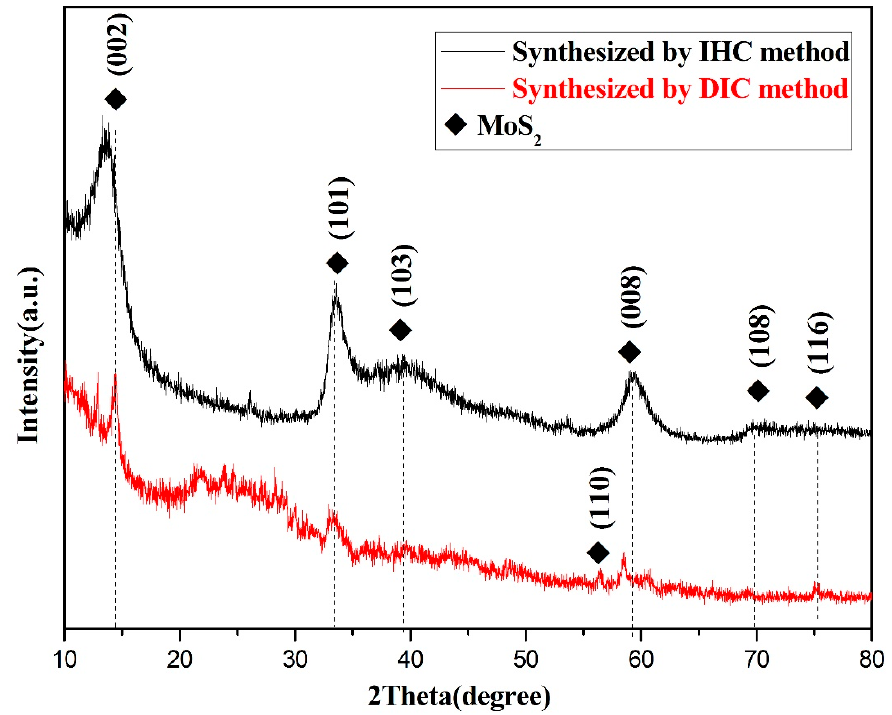
Figure 5. XRD patterns of MoS 2 /biocarbon obtained by DIC method and by IHC method.